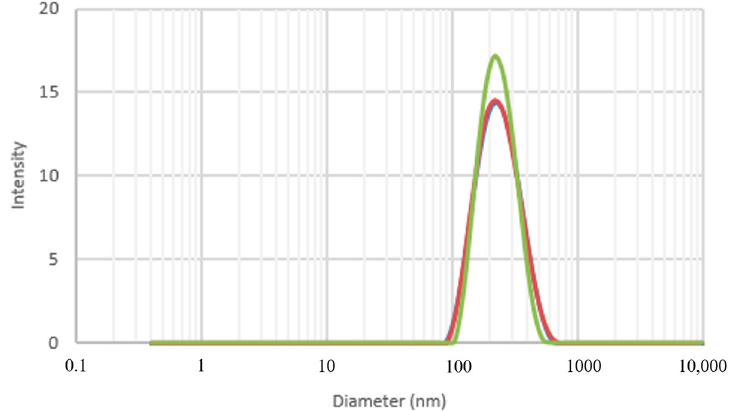
Figure 4. DLS analysis of the non-filtrated surfactant solution.